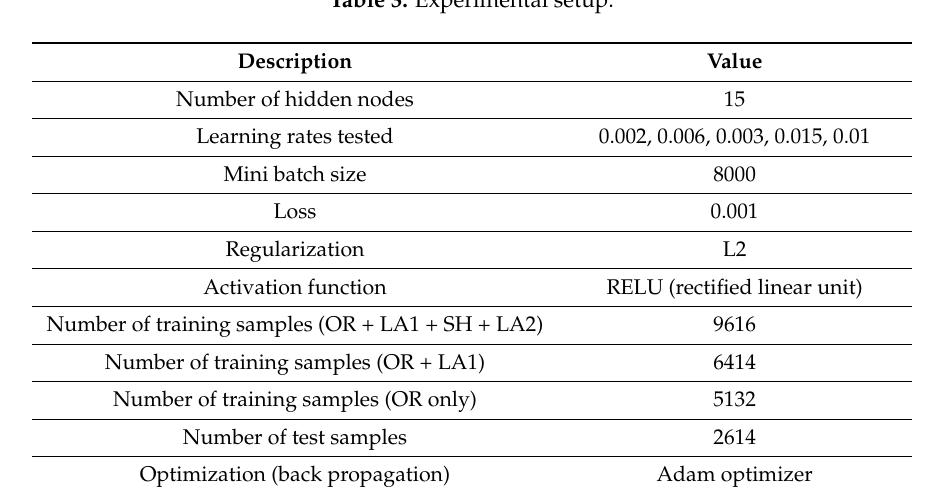
Table 3. Experimental